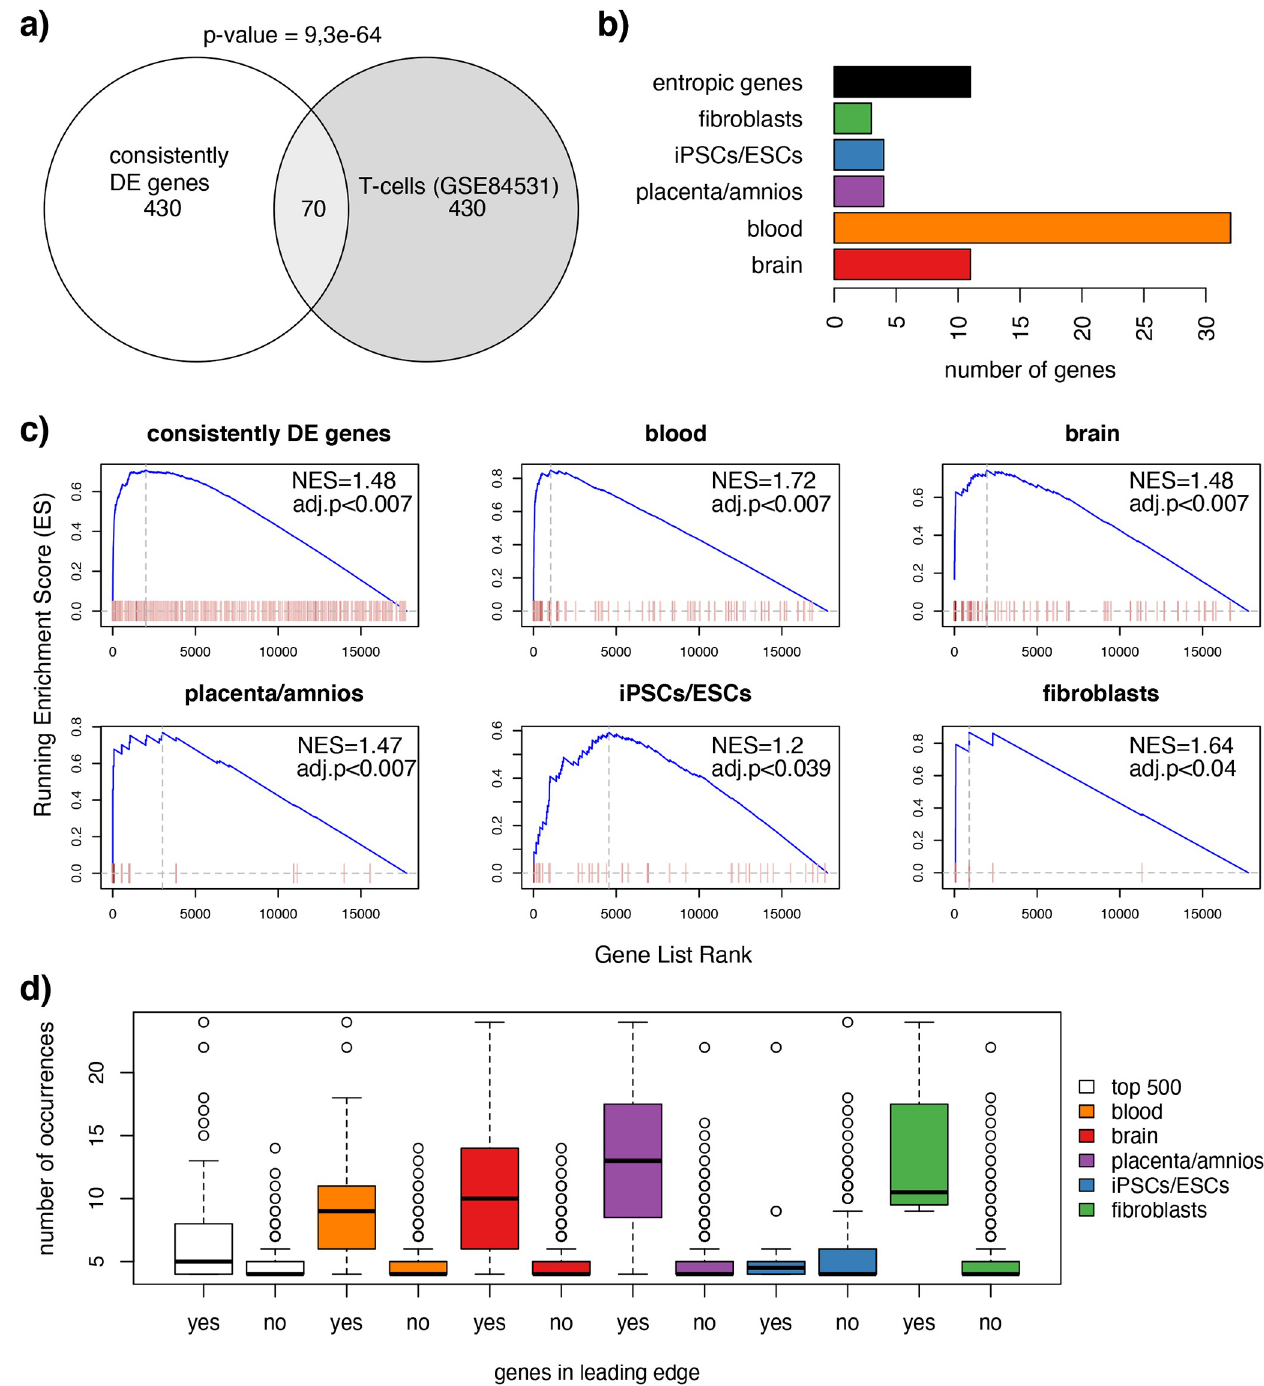
Fig 8. Genes DE in trisomic T-cells significantly overlap with our consistently DE genes, especially with genes consistently DE in blood. a) Venn Diagram showing the overlap between the consistently DE genes found in our meta-analysis and the top-DE genes in trisomic T-cells. The p-value of the fisher test for the enrichment is printed on top. b) Barplot showing the number of genes found DE in trisomic T-cells overlapping with the consistently DE genes in one or more tissue macro-category. c) Gene set enrichment for the top 500 consistently DE genes and the genes preferentially DE in each macro- categories across the list of the genes detected in trisomic T-cells ranked by their significance. Each red bar is a gene in the gene set, whose intensity of red is proportional to the number of occurrences. d) Boxplots showing the number of occurrences in the genes of the leading edge (left side of the distributions in panel c) compared to the ones not in the leading edge (right